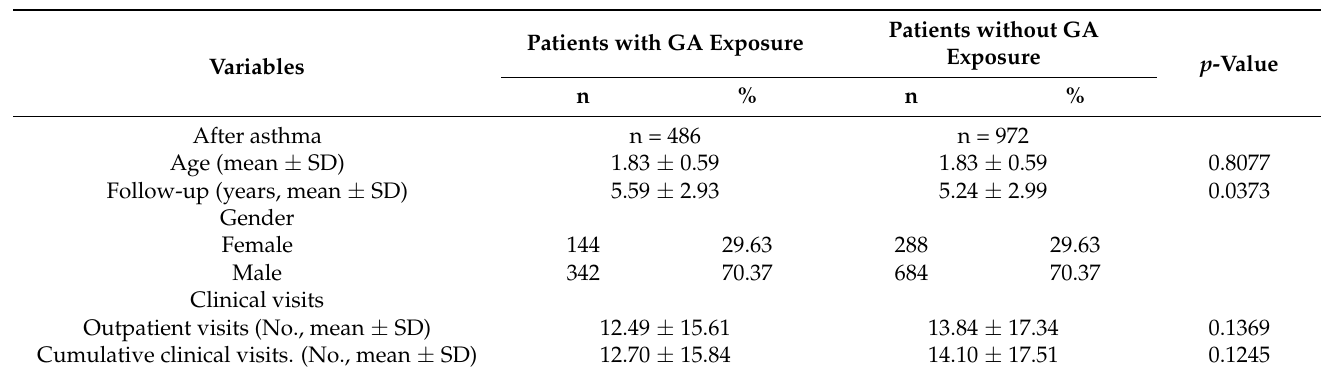
Table 2. Characteristics of the patients with asthma onset after general anesthesia (GA) exposure and unexposed subjects.